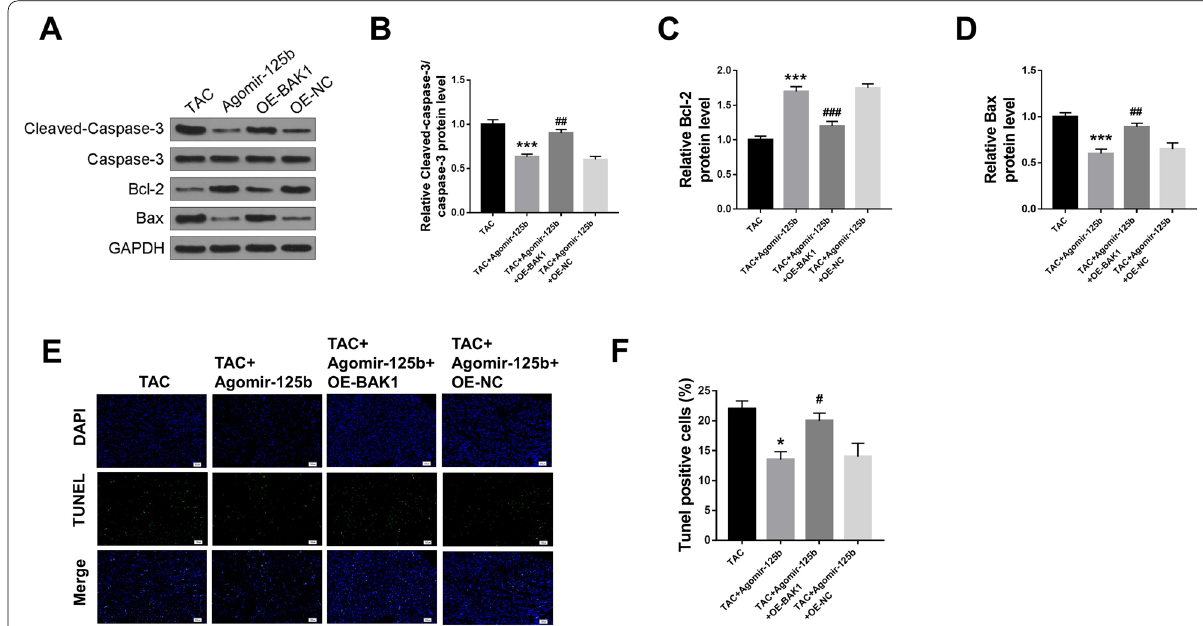
Fig. 6 BAK1 overexpression significantly reversed agomir-125b-inhibited cardiomyocyte apoptosis in HF mice. TAC mice were co-transfected with agomir-125b and OE-BAK1, or agomir-125b and OE-NC. A The protein expression of C-caspase 3, caspase 3, Bcl-2 and Bax in heart tissues was detected by western blot (n 5). B – D The relative expression changes in C-caspase 3 ( B ), Bcl-2 ( C ) and Bax ( D ) were analyzed by Image Lab ™ = Software (n 5). E Representative images of TUNEL staining of heart tissues by confocal microscopy (n = the ratio of TUNEL positive nuclei to DAPI-stained nuclei